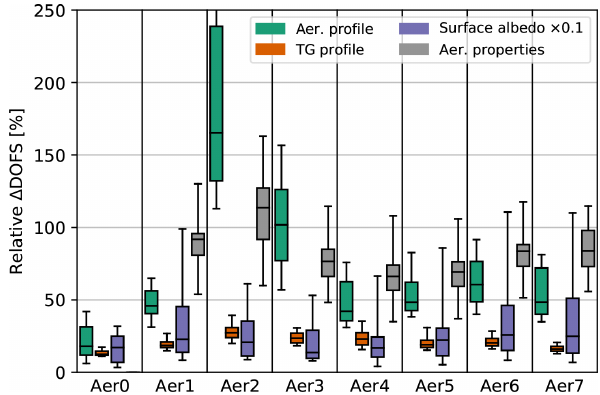
Figure 4. Box–whisker plots of relative DOFS increases result- ing from inclusion of polarimetric information, grouped by dif- ferent aerosol profile scenarios (different subplots) and parame- ter subgroups (box colours). (cid:49) DOFS is defined here as the dif- ference in DOFS values obtained with the polarimetric (Multi- S-P) and non-polarimetric (Multi-S) measurement modes. In this plot, box–whiskers represent the distribution of observed values: boxes encompass values between the 25th and 75th percentiles, while whiskers indicate the 5th and 95th percentiles. Horizontal line markers within the boxes indicate median values.